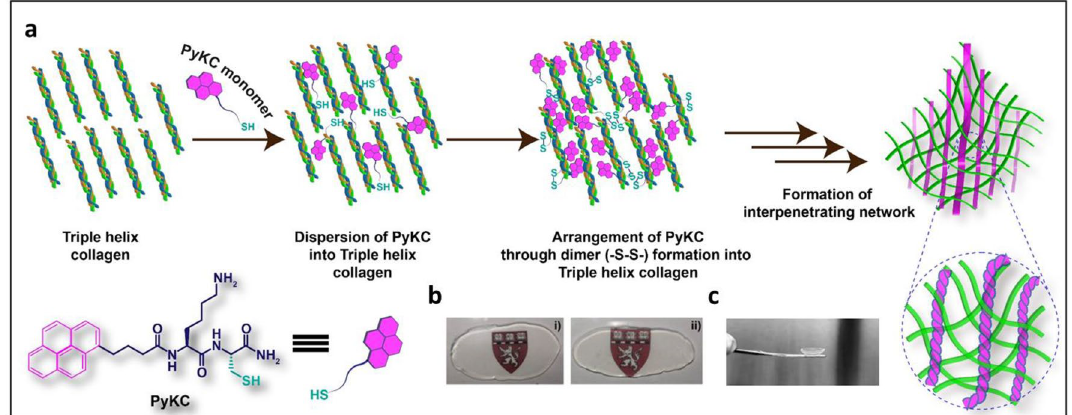
Figure 1. ( a ) Schematic representation of the crosslinker free Coll-PyKC hydrogel generated by forming an interpenetrating network. ( b ) Transparency of the hydrogels as illustrated by photography of Coll-PyKC hydrogels from Coll 10 -PyKC 1 (i), Coll 10 -PyKC 2 (ii) on Harvard logo. ( c ) Photograph of cornea-shaped hydrogel prepared from Coll